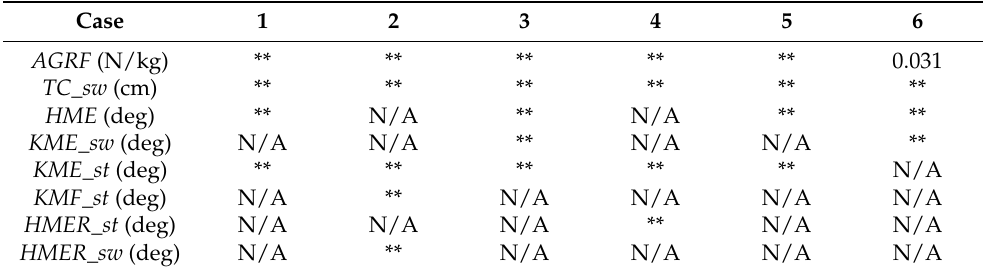
Table 4. Gait metric comparisons between CP ( noFES1 ) and typically developing reference dataset ( TD ).